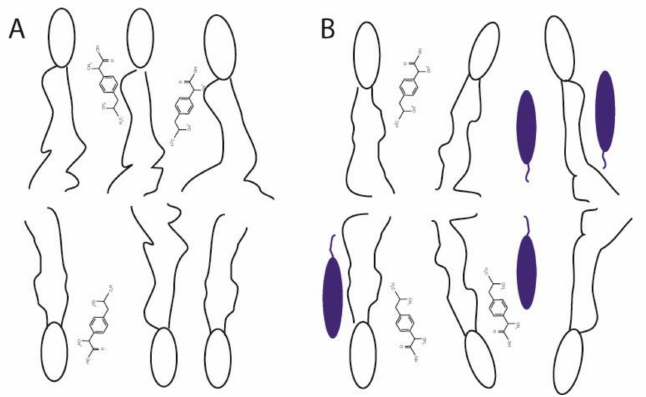
Figure 7. Sketch of the membrane position and orientation of ibuprofen in ( A ) a POPC membrane and ( B ) POPC / cholesterol membrane deduced from the NOESY data in this study. Cholesterol molecules are represented by the blue ellipses.